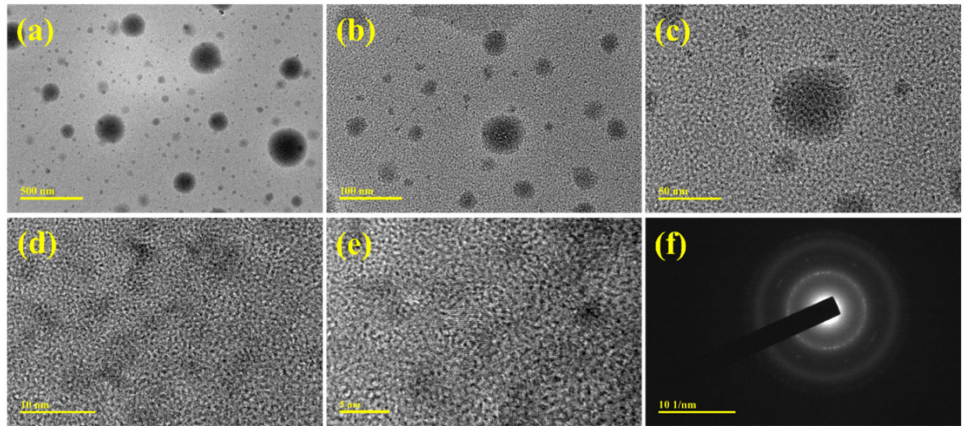
Figure 5. ( a – c ) TEM images, ( d , e ) HTREM images, and ( f ) the corresponding SAED pattern of PANI nanoparticles.